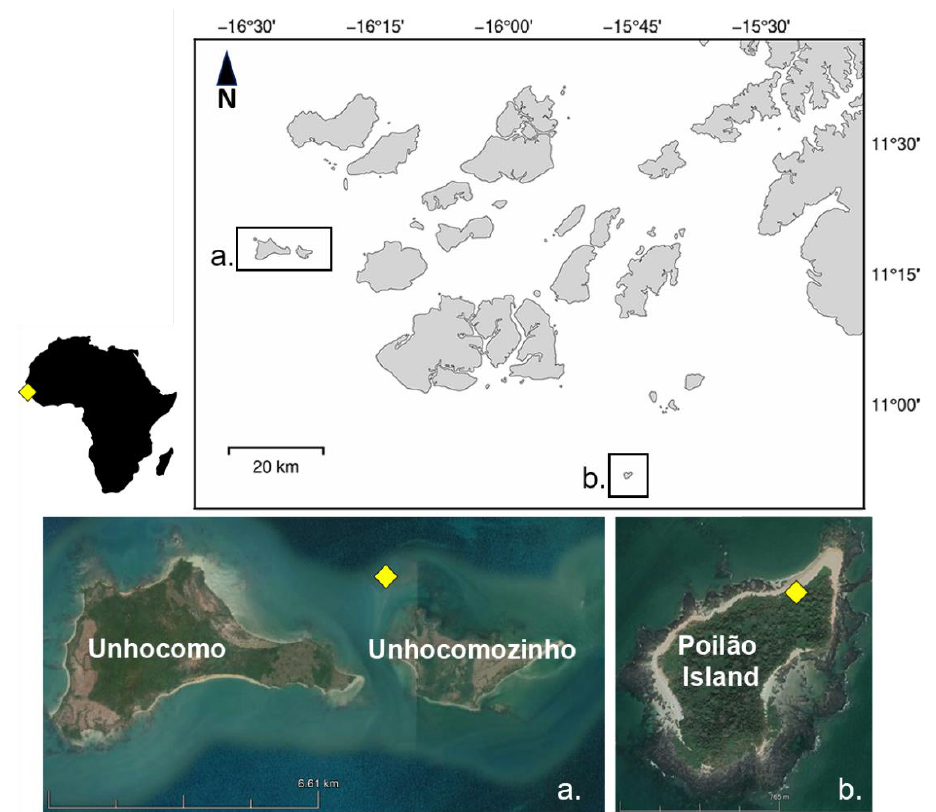
Figure 1. Map of study sites in the Bijagós Archipelago, Guinea-Bissau: ( a ) Unhocomo and Unhocomozinho islands; ( b ) Poilão, island.